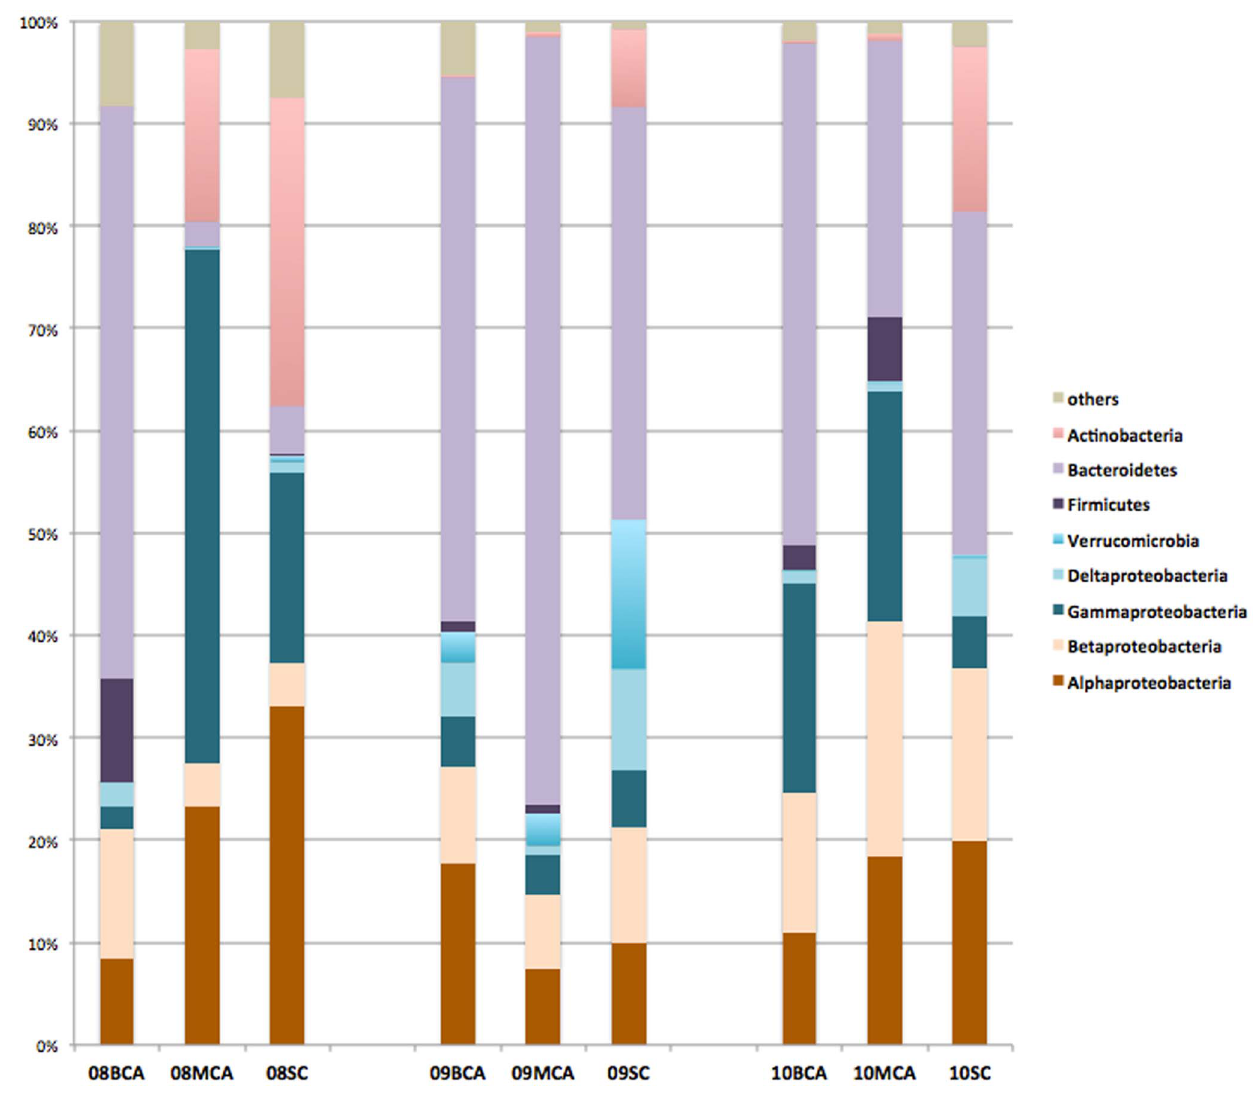
Figure 4. Relative abundance and bacterial composition obtained by pyrosequencing from phycosphere samples in September and October, by phylum. Phylogenetic classification for the pyrosequencing analysis obtained from Ribosomal Database Project Classifier analyses.